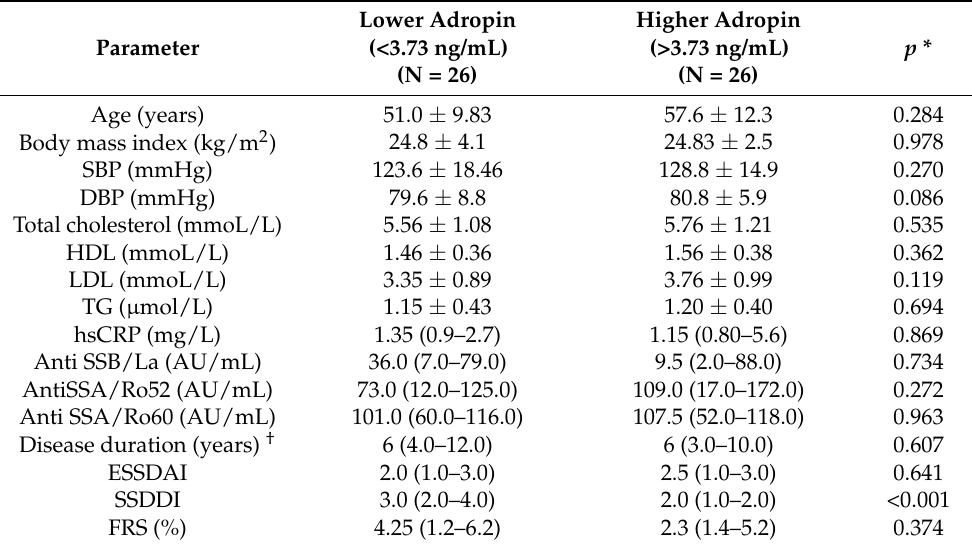
Table 3. Characteristics of primary Sjögren’s syndrome patients based on adropin level.